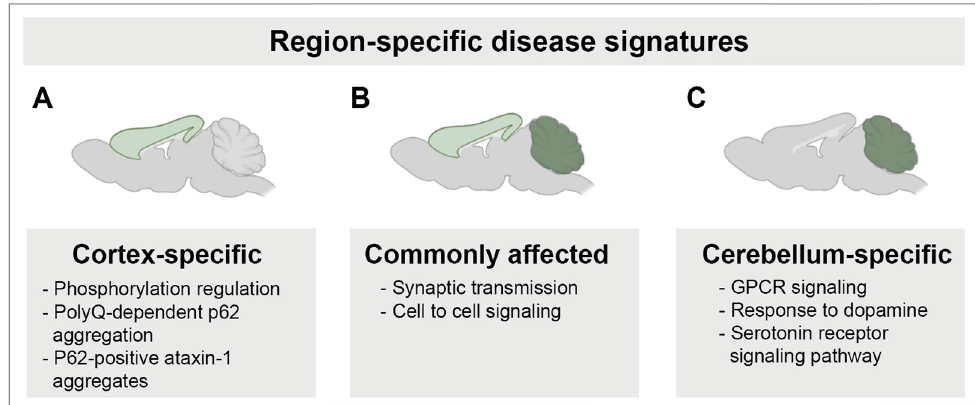
Figure 6. Schematic of shared and region-specific changes observed in the SCA1 KI mouse cortex and cerebellum during early stage of the disease at 12 weeks. ( A ), Cortex-specific changes observed in the SCA1 KI mice include region-specific differences in p62 aggregation colocalizing with ataxin-1 nuclear inclusions, and phosphorylation regulation. ( B ), Shared SCA1 disease signatures include synaptic transmission and cell to cell signaling. ( C ), Cerebellum-specific changes identified in the SCA1 KI mice include GPCR signaling, response to dopamine, and serotonin receptor signaling pathway.